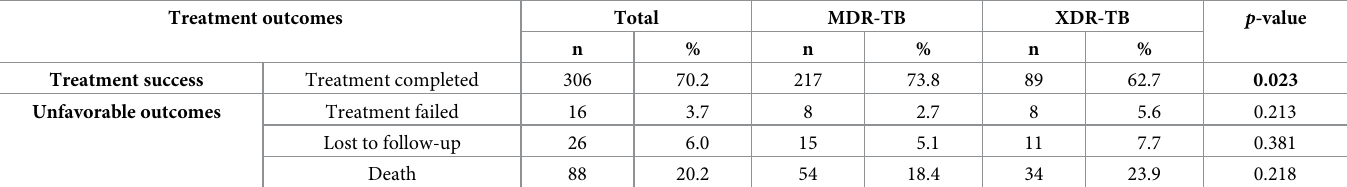
Table 2. Treatment outcomes among multidrug-resistant and extensively drug-resistant tuberculosis patients who started treatment between 2000 and 2016 (n = 436). Treatment